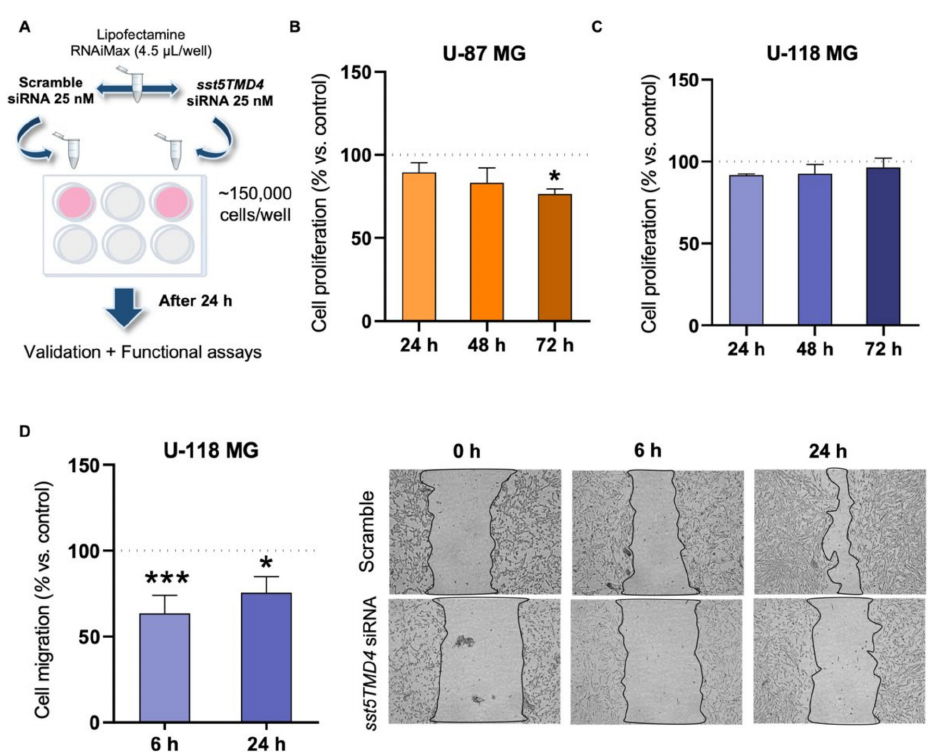
Figure 4. sst5TMD4 silencing promotes the reduction of oncogenic features in vitro in glioblastoma cells. ( A ) Schematic diagram followed to obtain silenced sst5TMD4 GBM cells (U-87 MG and